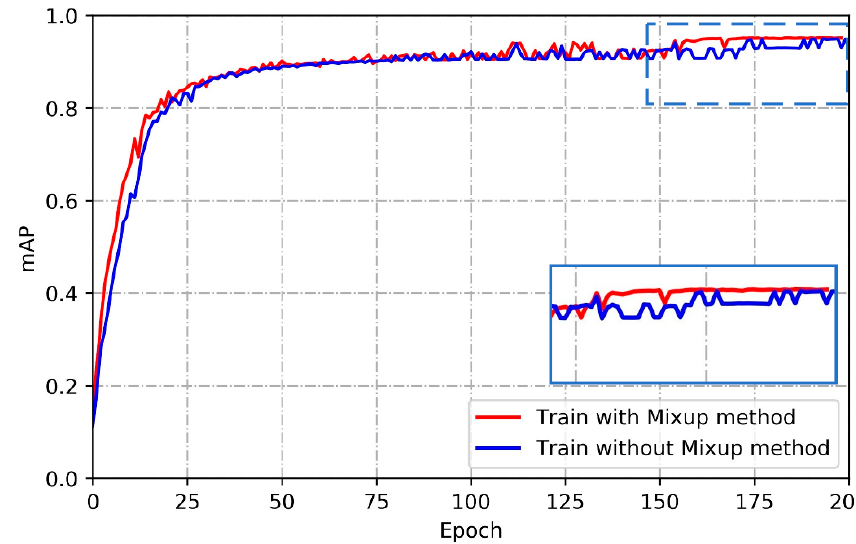
Figure 16. mAP curves of the two methods.